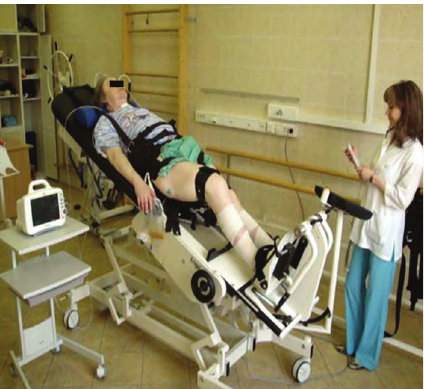
Figure 1: The device combining tilt-table functionality with step- ping movement is